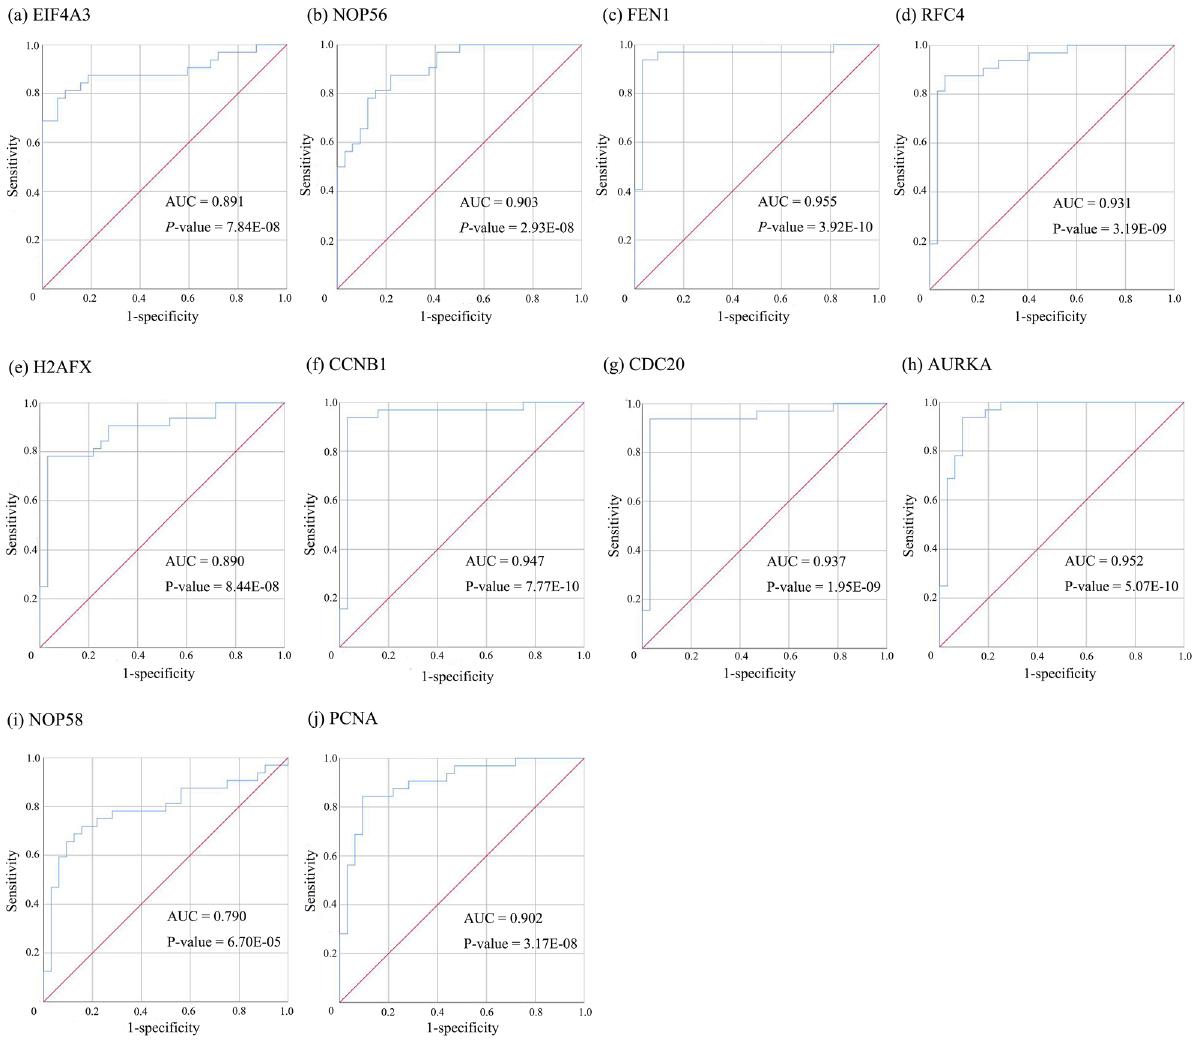
Figure 10. The ROC curves of key genes identified by GCNA-kpca algorithm. These ROC curves described the diagnostic efficiency of the mRNA levels of 10 key genes for HCC and normal tissues. This figure was drawn with IBM SPSS Statistics 25